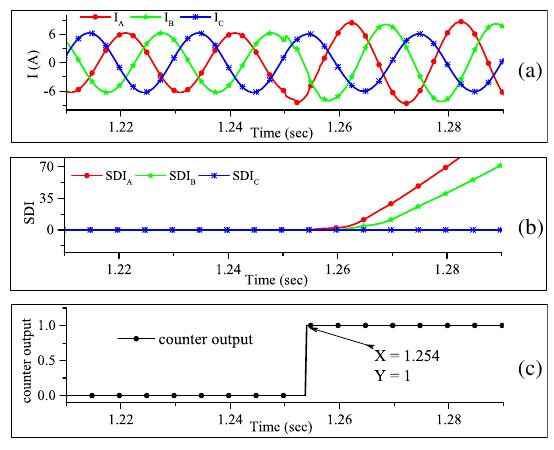
Fig. 3 ABg fault with High resistance: ( a ) Current waveforms, ( b ) SDI trajectories ( c ) Counter output